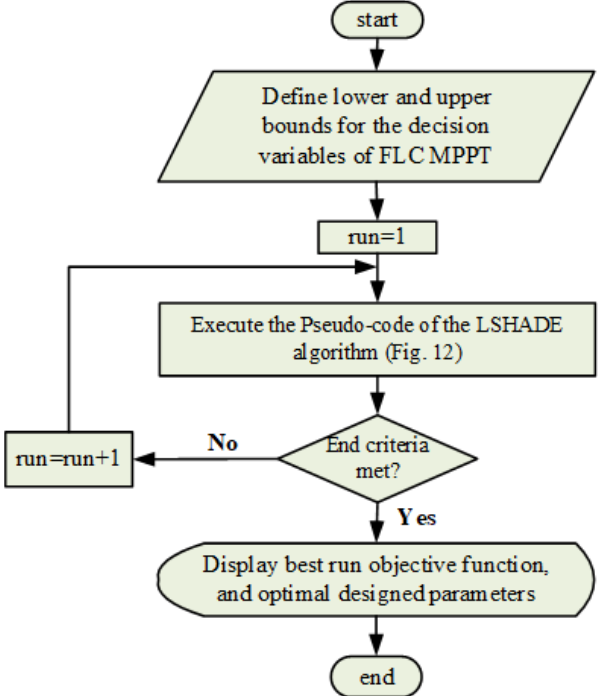
Figure 11. The stages of proposed LSHADE-based FLC design optimization.